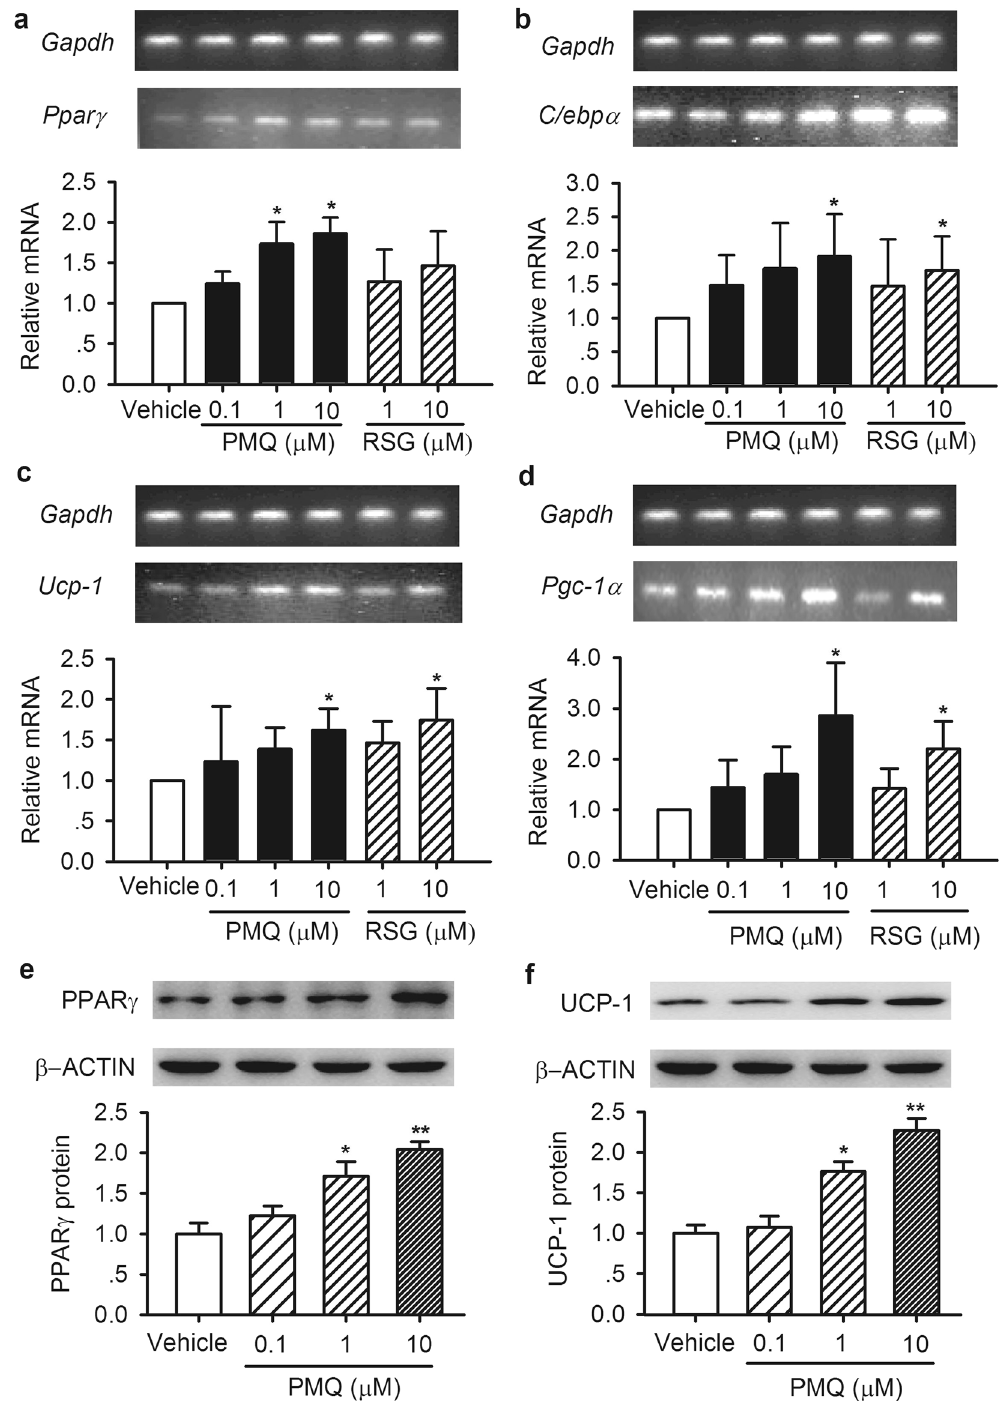
Figure 3. PMQ upregulated the mRNA/protein expression levels of adipogenesis transcription factors and thermogenic-related genes in 3T3-L1 adipocytes. Cells were incubated with different concentrations of PMQ from Days 0–8. ( a–d ) Relative mRNA levels of Ppar γ , C/ebp α , Ucp-1 and Pgc-1 α in 3T3-L1 adipocytes treated with or without PMQ. Rosiglitazone-treated cells served as positive controls. ( e,f ) Western blot analysis of PPAR γ and UCP-1 protein expression in 3T3-L1 adipocytes treated with the indicated agent. The gels or blots were cropped as indicated. The data are expressed as the mean ± SEM. n = 3 experiments, * p < 0.05, ** p < 0.01 vs